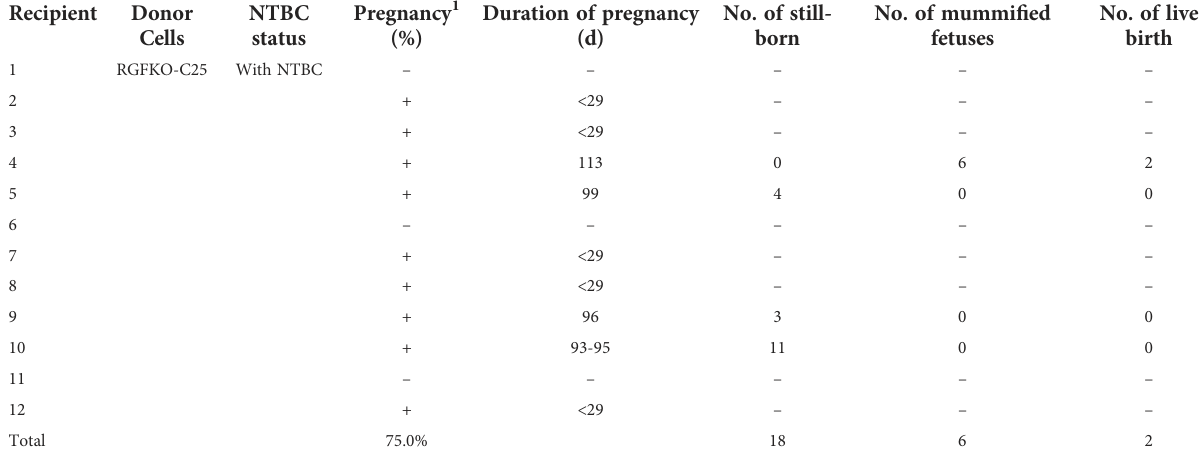
TABLE 3 Summary of the generation of RGFKO pigs by somatic cell nuclear transfer in sows with NTBC supplementation (Group B). Recipient